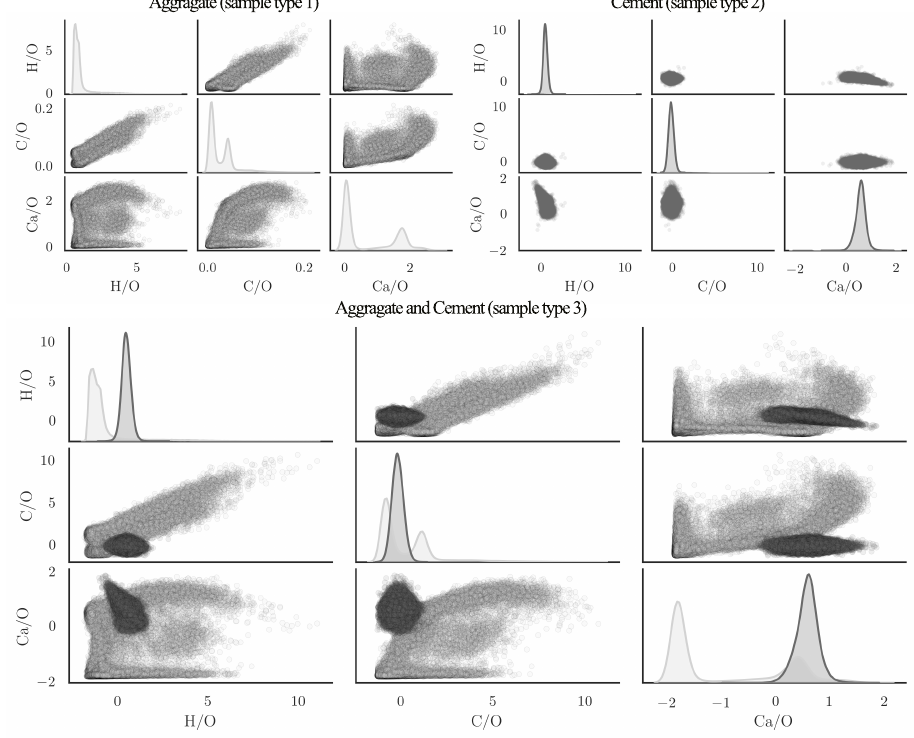
Figure 4. Pairwise plot of scaled virtual concrete in VIS-NIR